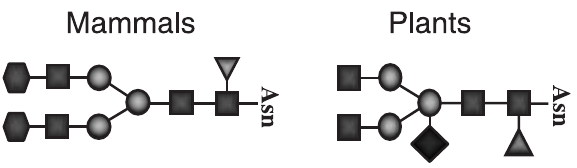
Figure 1 Schematic representation of complex N -glycans from mammals and plants